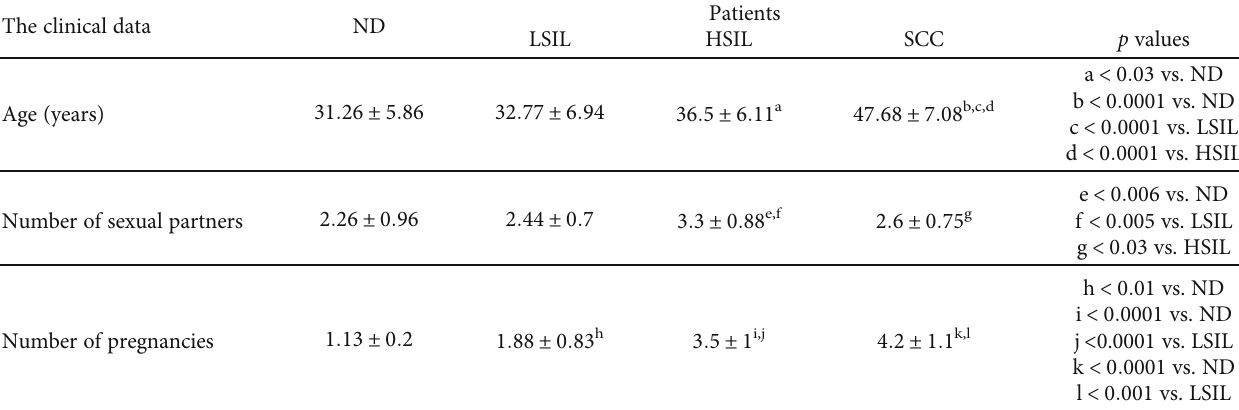
Table 3: Correlations between clinical data of NDs and patients with di ff erent cervical squamous cell abnormalities. The clinical data ND